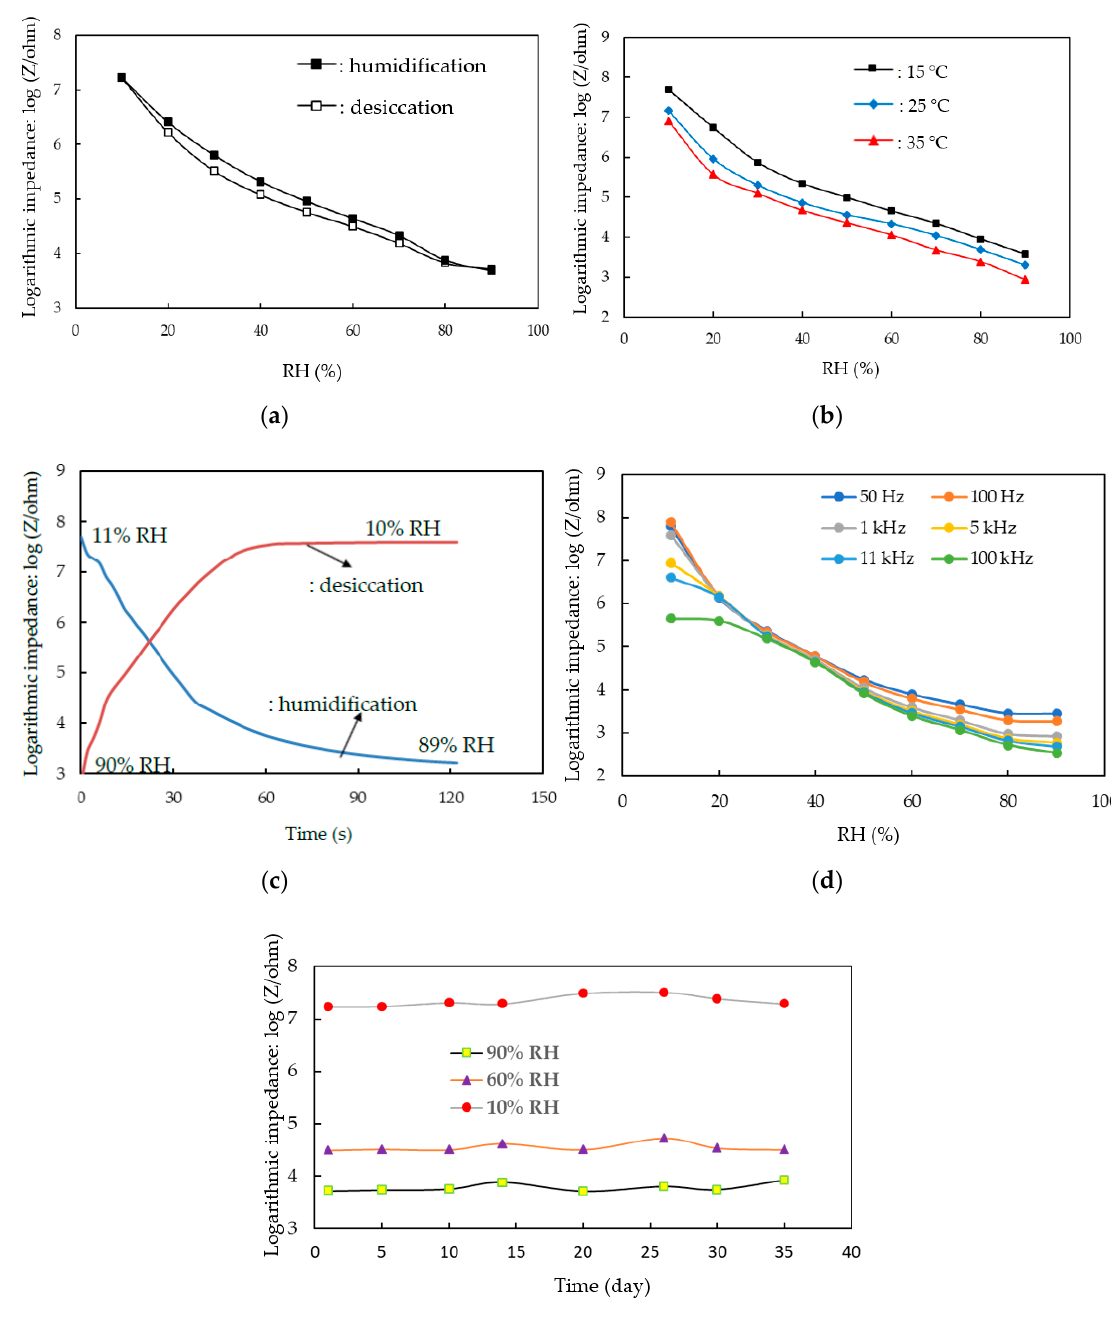
Figure 7. Humidity-sensing properties of the humidity sensor that was made of Ag MWs (6 mg)/PPy (0.1 g)/SnO 2 ternary composite film. ( a ) Hysteresis of the sensor, ( b ) effect of ambient temperature on the response of the sensor, ( c ) response/recovery times of the sensor, ( d ) effect of applied frequency on the response of the sensor, ( e ) long-term stability of the sensor. Table 2. Humidity sensor performance of this work compared with the literatures based on the SnO 2 - based humidity sensors. Sensing Material Working Range Sensitivity (% RH)